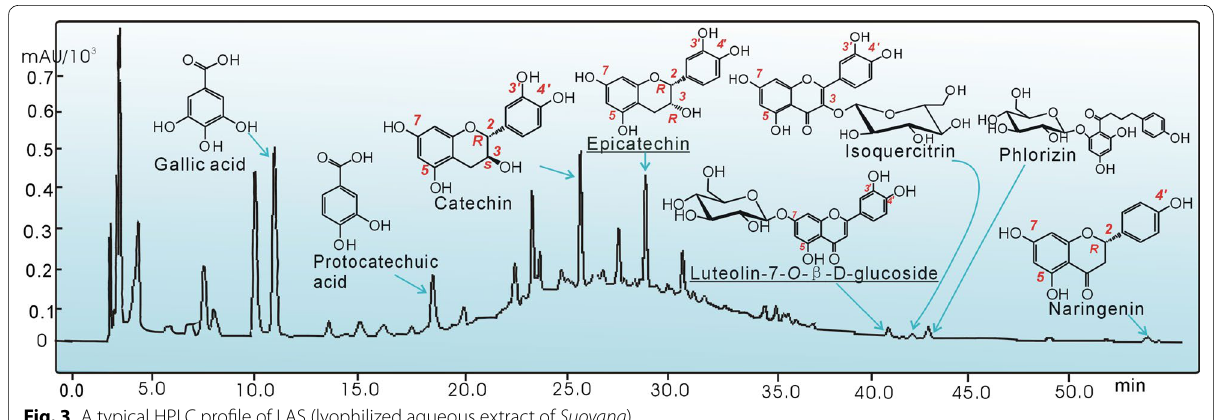
Table 1 The A of LAS, epicatechin, and luteolin-7- O - 490nm β -D-glucoside towards •OH-damaged MSCs in MTT assay